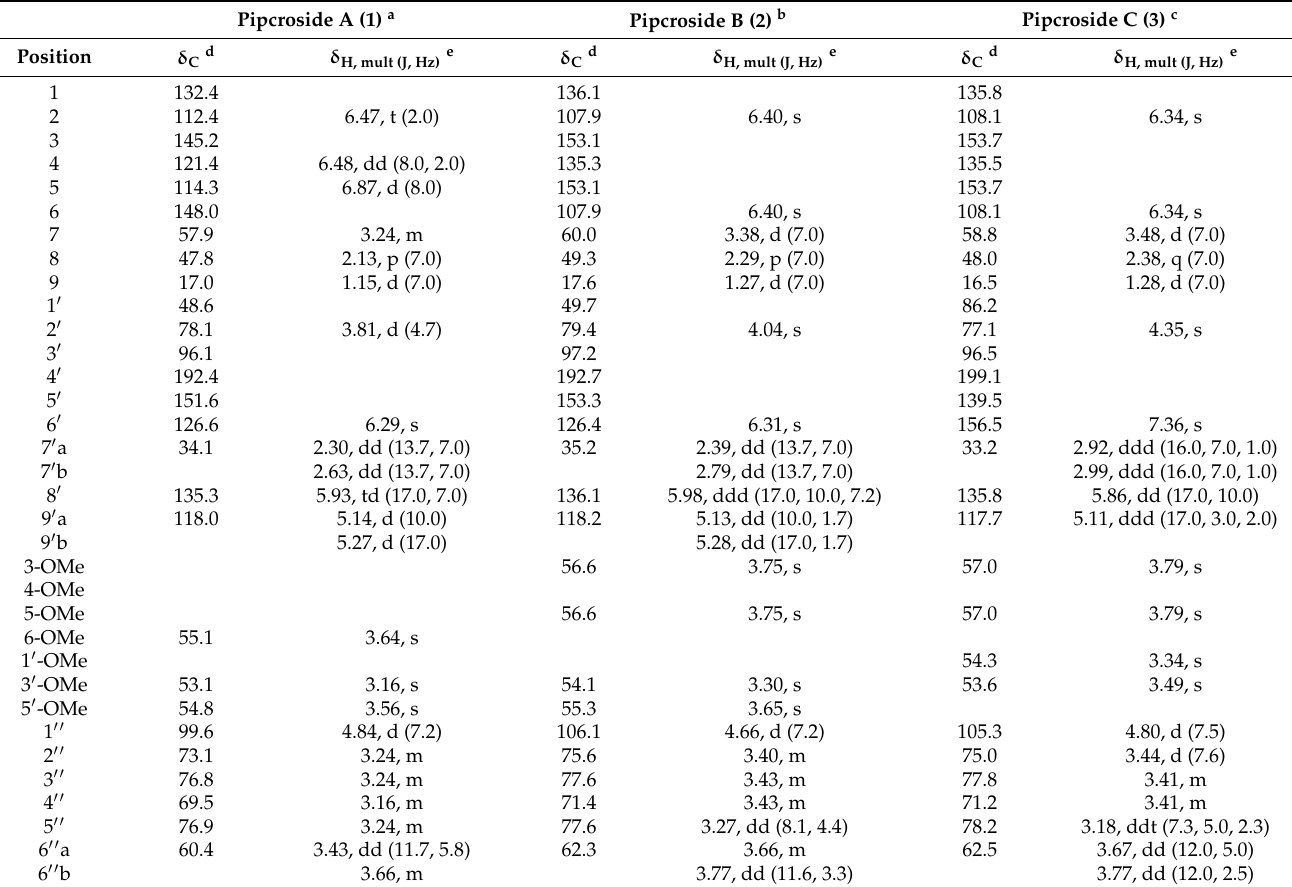
Table 1. 1 H and 13 C NMR data of compounds 1 – 3